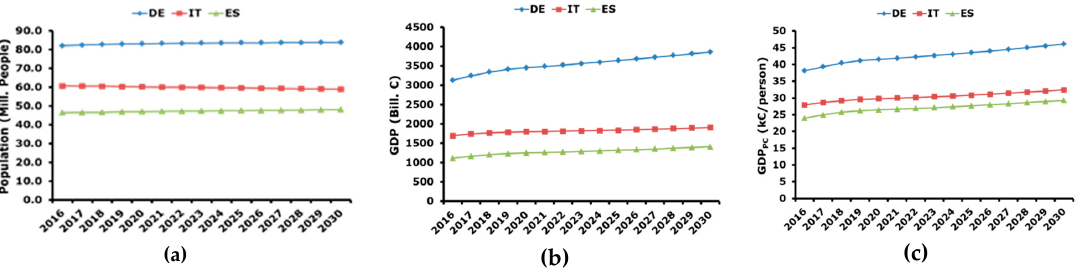
Figure 6. Forecasting of GDP per capita: ( a ) evolution of population; ( b ) GDP nominal values; ( c ) projection of GDP per capita.